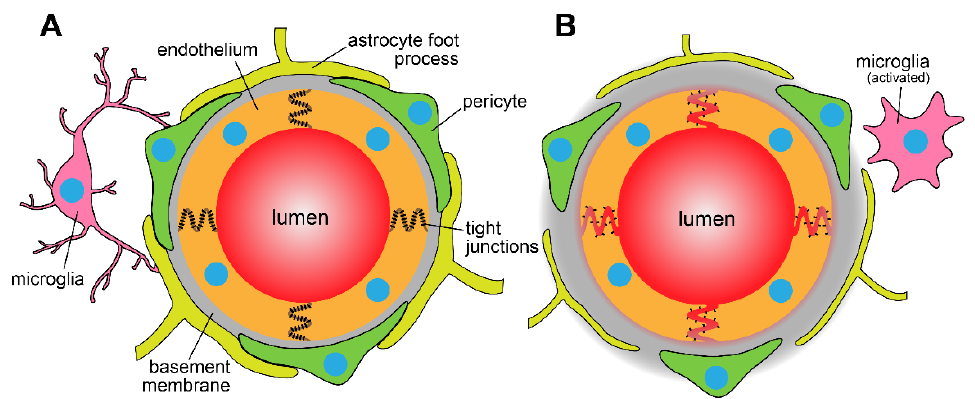
Figure 1. Anatomical differences between ( A ) blood–brain barrier vasculature and ( B ) disrupted BBB. The BBB is characterized by presence of endothelial tight junctions, formed by the tight junction proteins and the adjacent pericytes, microglia and astrocytic foot processes.